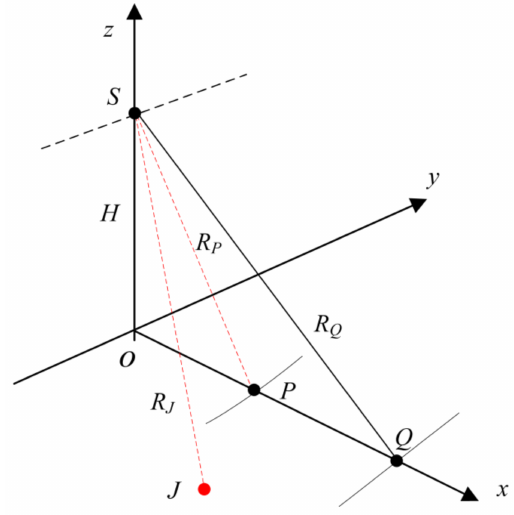
Figure 1. The beyond-PRT RDJ